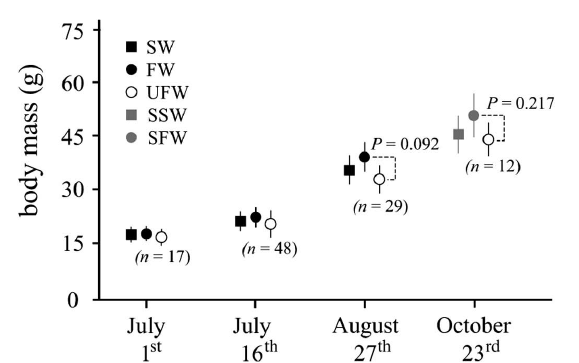
Fig. 1. – Evolution of mean body mass (±SE) of UFW sea bass ( Dicentrarchus labrax ) compared with the body mass of 30 SW and FW fish (July 1, July 16, August 27), or 20 SSW and SFW fish (Oc- tober 23) (see text for details). Samples of UFW fish represent pools of individuals that demonstrated signs of abnormal behaviour three days before and after those dates, except for the final date October 23, with UFW individuals collected over the 10 days before this date because no mortality peak was observed at that time. Sample sizes of UFW pools are indicated in brackets. No significant differ- ences in body mass were found among groups of fish at each date. Only the lowest observed p-values recorded between UFW fish and fish sampled in FW during the last two surveys are indicated. Note that (S)SW fish always have an intermediate average body mass compared with other fish categories, suggesting that they could be a mixture of cryptic